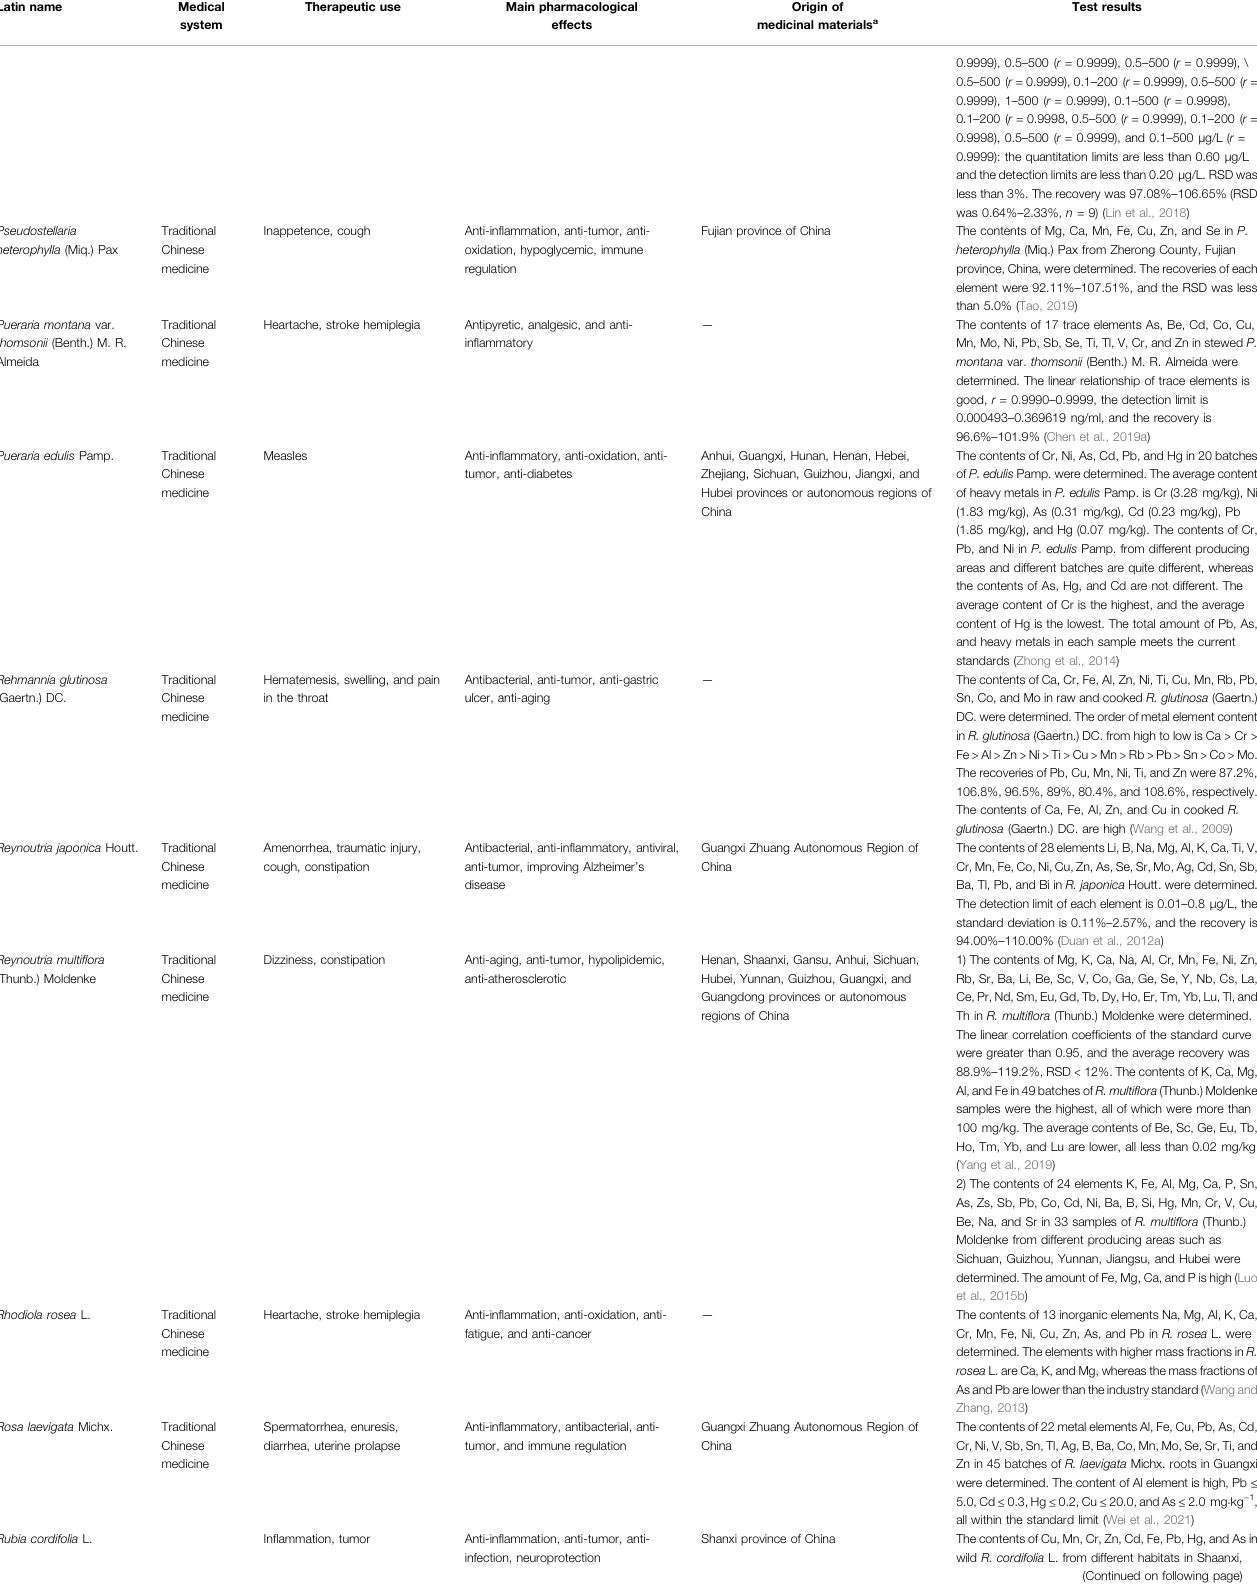
TABLE 1 | ( Continued ) Application of ICP-MS in the determination of heavy metal elements in medicinal materials derived from the roots of